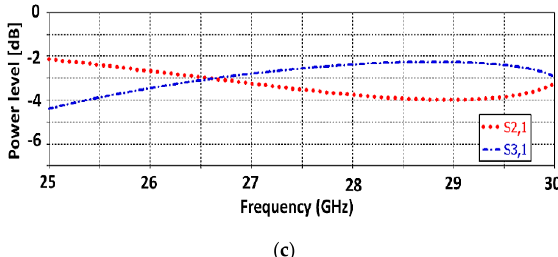
Figure 6. Two-way H-plane SIW power divider with 120-degree phase difference; ( a ) structure, ( b ) output port phase difference, ( c ) power levels between 25 and 29 GHz.